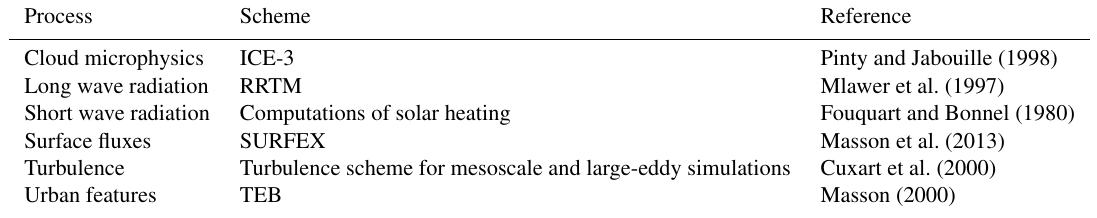
Table 2. Parameterization schemes in AROME